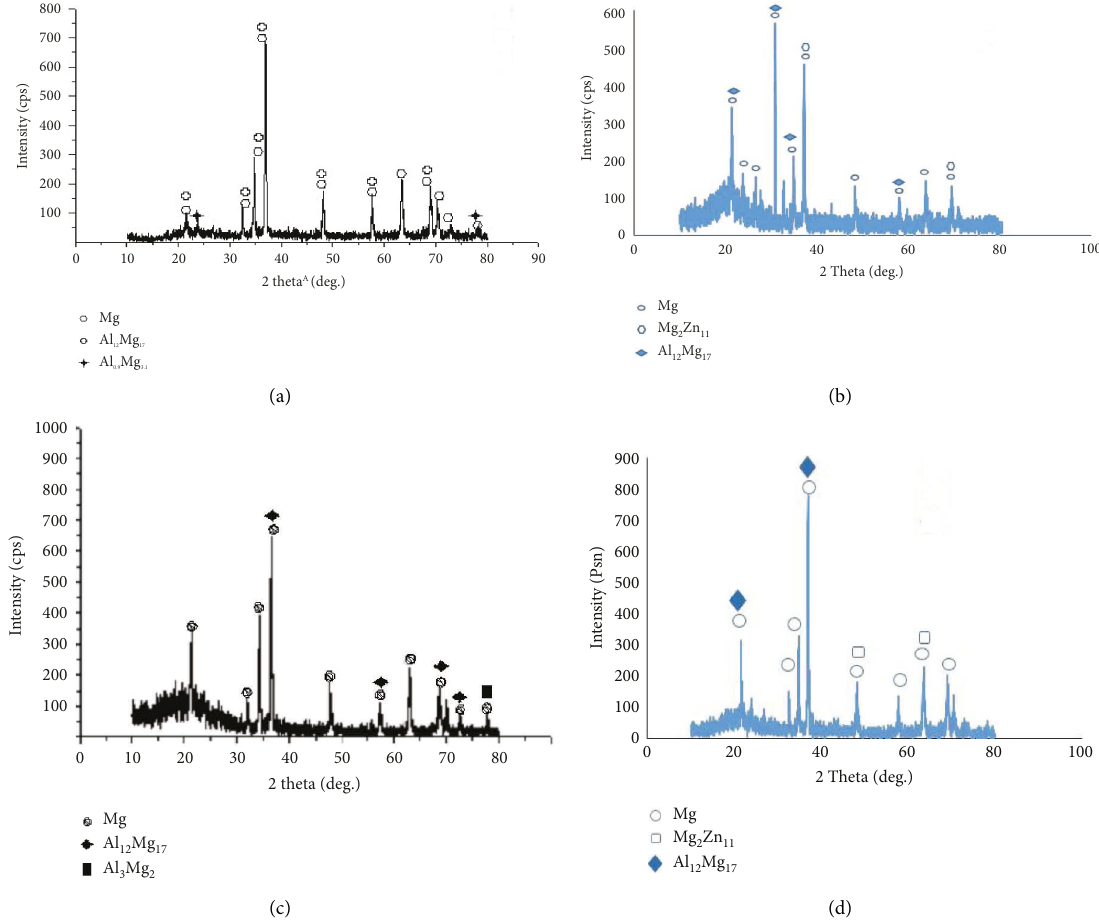
Figure 8: XRD results. (a) Base metal. (b) CCGTAW. (c) PCGTAW. (d)